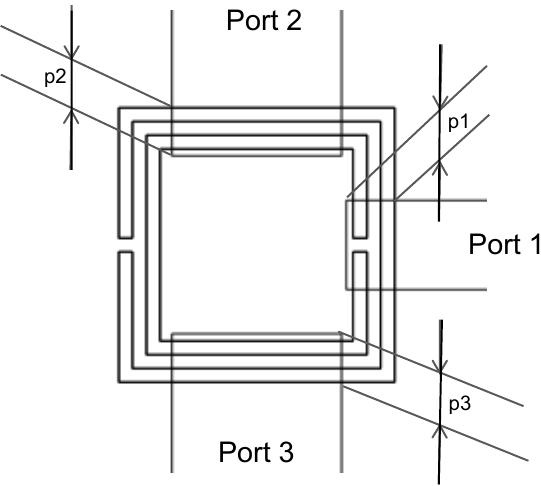
Figure 8. Detailed top view and relevant dimensions.